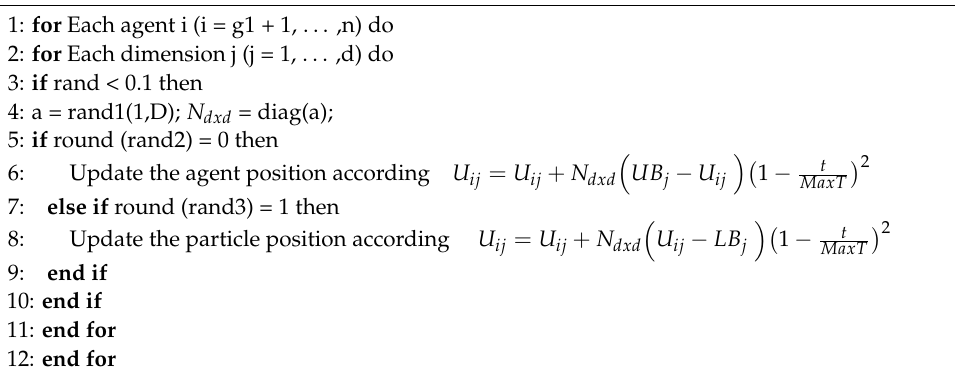
Algorithm 1 Pseudo code of the non-uniform